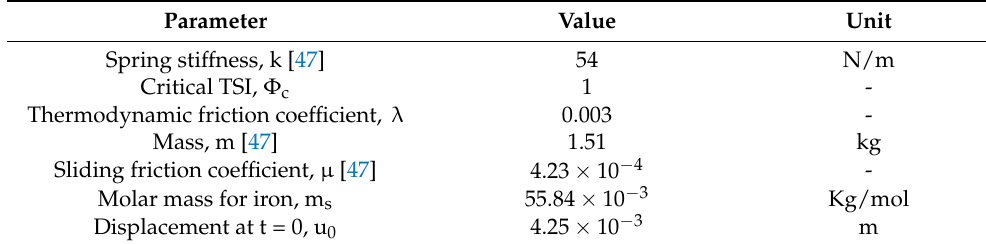
Table 2. List of parameters used to compare the proposed model and the Newtonian mechanics equation with experimental